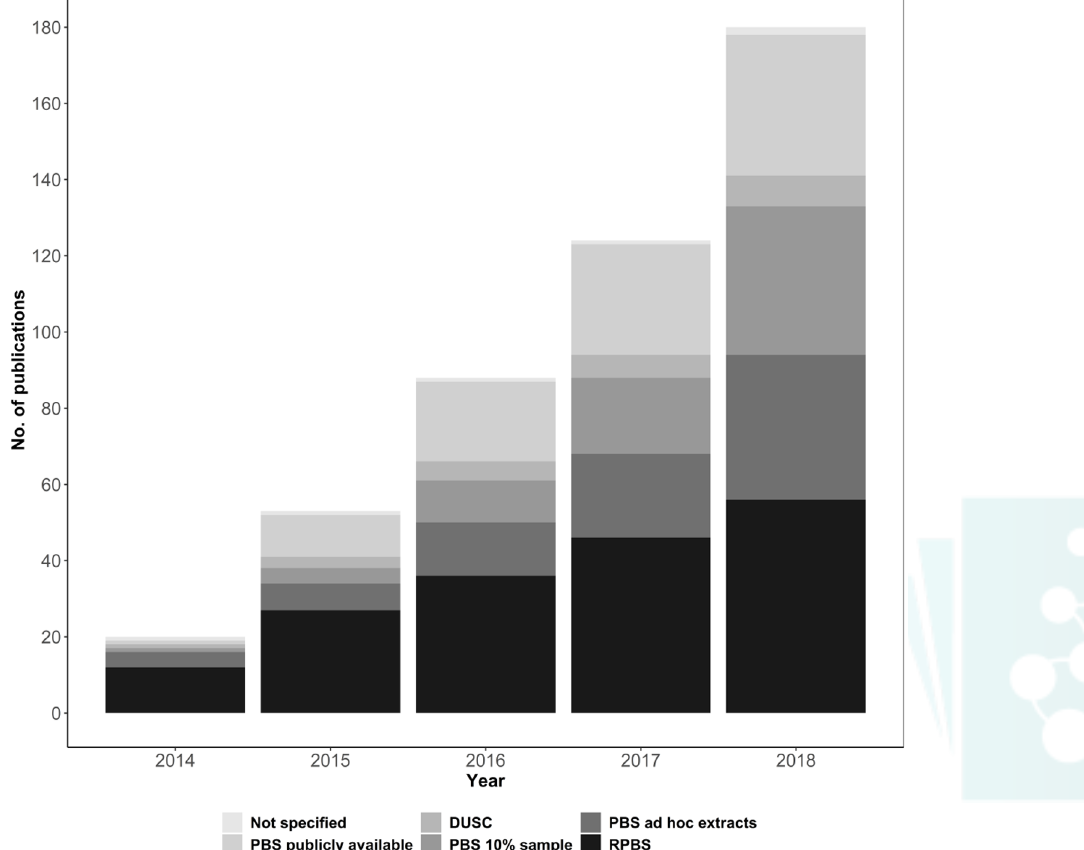
Figure 2: Number of publications (cumulative) according to primary dispensing claims